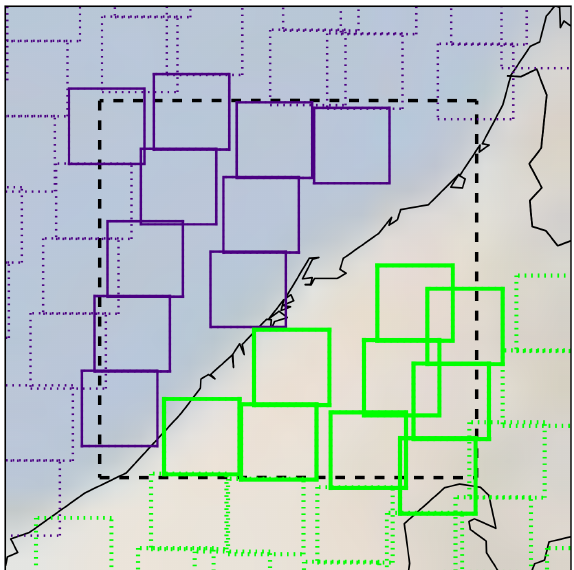
Figure 1. Example of a coastal L3 grid box (dashed black box) and bounded L2 retrievals from which the L3 products for that grid box are created. Purple (green) boxes correspond to L2 retrievals with a surface index of “water” (“land”). Note that only L2 re- trievals with a midpoint that falls within the boundaries of the L3 grid box will be used in L3 creation for that grid box. These are indicated by solid purple/green outlines – those not included in L3 creation for this grid box are shown with dotted purple/green out- lines. More information on surface indexing and L3 product cre- ation is given in Sect. 2.2. “Coastal” L3 grid box classification is outlined in Sect. 2.3. The coastal L3 grid box visualised here con- tains the city of Dubai ( ∼ centre at 25.277 ◦ N, 55.296 ◦ E), which features in the case study analysis of Sect. 3.4. Faint background shading is from NASA Blue Marble